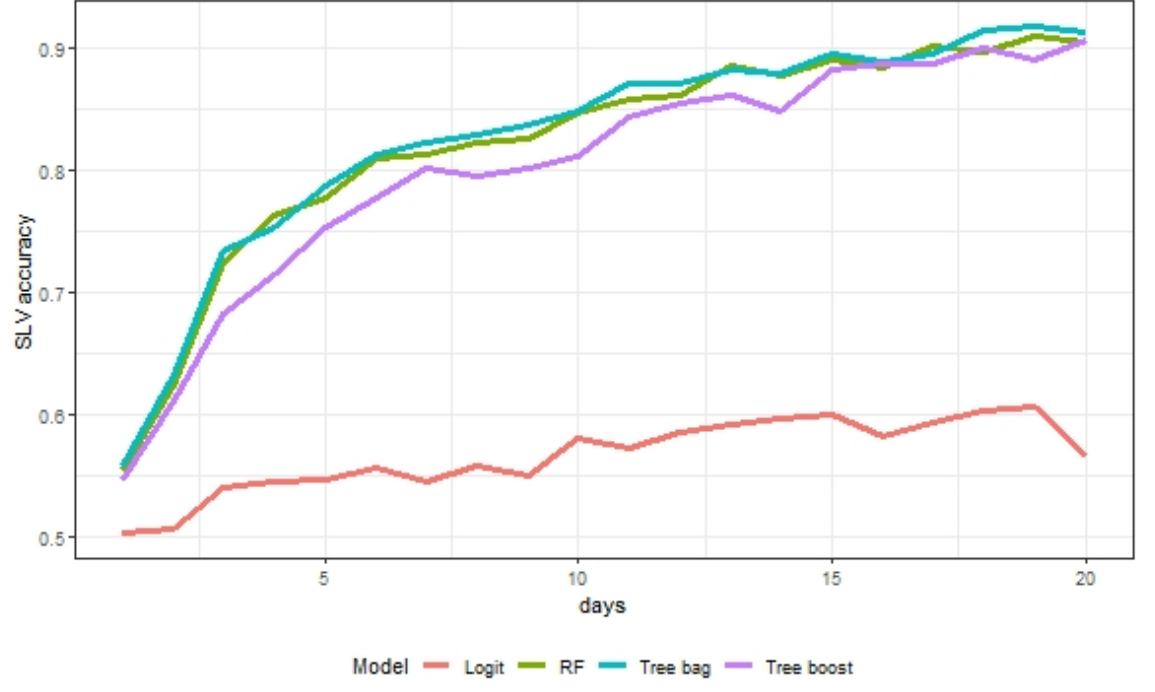
Figure 5. This figure shows the multi-period prediction accuracy for SLV price direction.